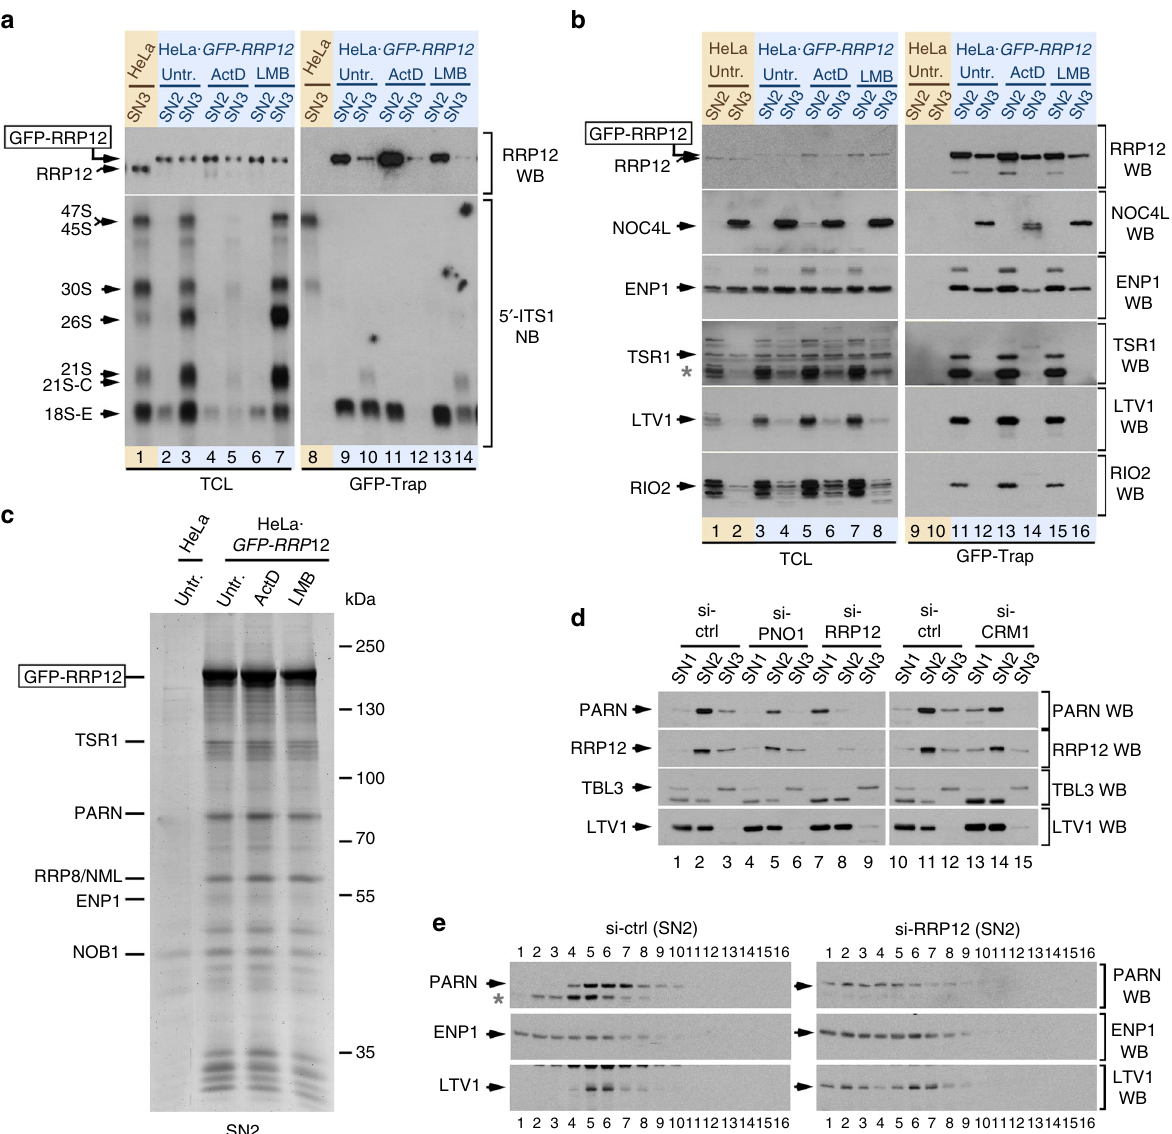
Fig. 6 Pre-40S particles incorporate the PARN ribonuclease in the nucleolus. a Co-puri fi cation of pre-rRNA species with GFP-RRP12 extracted in the SN2 and SN3 steps of the PSE method from cells untreated or treated with ActD or LMB for 2 and 1.5 h, respectively. GFP-Trap preparations from SN2 and SN3 fractions of HeLa cells and HeLa-derived (HeLa (cid:129) GFP-RRP12 ) cells endogenously expressing GFP-RRP12 were analyzed by Northern blot using the 5 ′ -ITS1 probe (right bottom panel). A parallel Northern blot analyzed total RNAs prepared from the same samples used for GFP-Trap puri fi cations (TCL, left bottom panel). Western blot analyses revealed the GFP-RRP12 content present in the total fraction samples (left top panel) and GFP-Trap puri fi cations (right top panel). b Interactions of several RBFs with GFP-RRP12 extracted in the SN2 or SN3 fractions from HeLa and HeLa (cid:129) GFP-RRP12 cells untreated or treated with ActD or LMB. GFP-Trap preparations were obtained as described in a and the amounts of bait (right top panel) and co-purifying RBFs (right panels underneath top panel) analyzed by Western blot. A parallel Western blot analyzed the contents of all proteins in the total fraction samples (left panels). The asterisk indicates a band from previous hybridization of membranes with another antibody. c Proteins associated to GFP-RRP12 extracted in the SN2 step of the PSE method. GFP-Trap preparations were obtained from the SN2 fractions of HeLa and HeLa (cid:129) GFP-RRP12 cells untreated or treated with ActD or LMB. Major co-purifying bands were sliced from the gel and identi fi ed by mass spectrometry. d Relative content of PARN, RRP12, TBL3, and LTV1 in the SN1, SN2, and SN3 fractions obtained with the PSE method from HeLa cells transfected with the indicated siRNAs and harvested 48 h after transfection. e Sedimentation properties of PARN-containing complexes present in the SN2 fraction from HeLa cells after depletion of RRP12. Cells were transfected with the control or RRP12 siRNAs and collected for sucrose-gradient sedimentation analyses 48 h after transfection. The contents of PARN, ENP1, and LTV1 in each fraction of the gradients were analyzed by Western blot. Asterisk indicates a non-speci fi c band recognized by the PARN